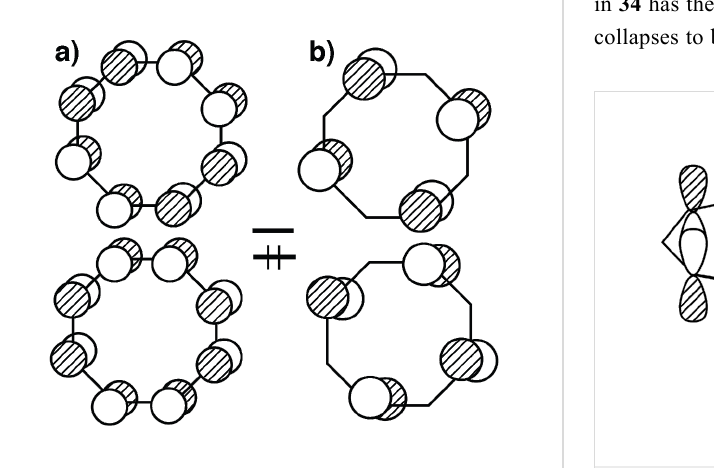
Figure 10: The two important bonding interactions for transition state 31 are drawn in 33 and 34